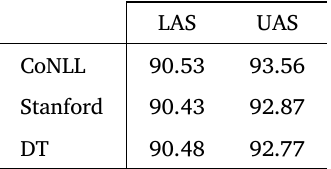
Parsability of three dependency schemes, measured as labeled attachment score (LAS) and unlabeled attachment score